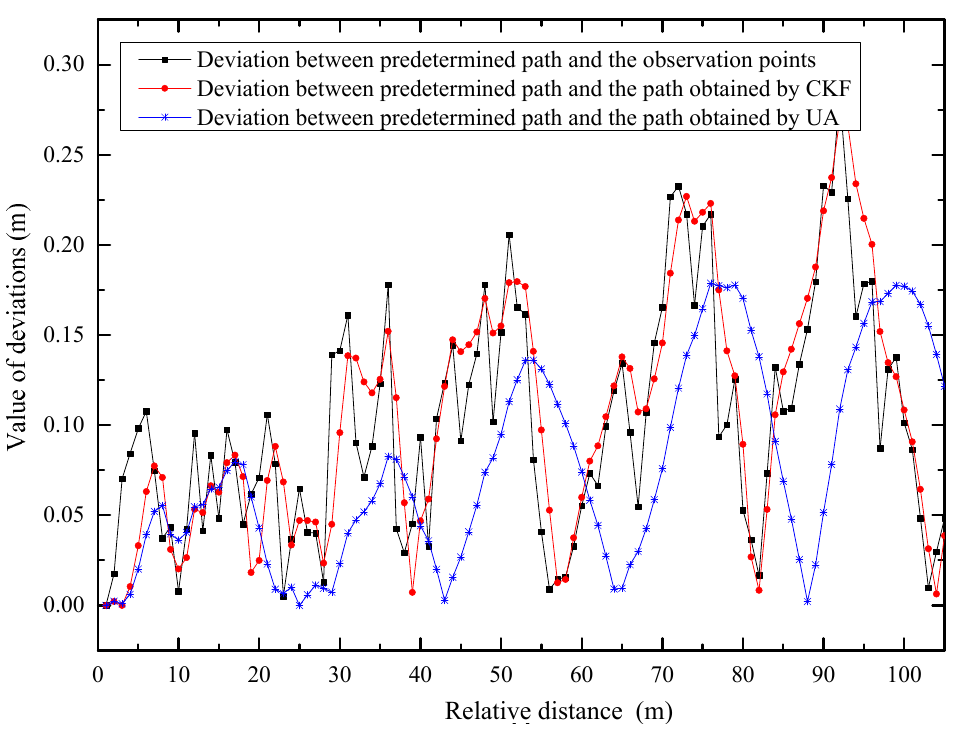
Figure 7. Deviations between the predetermined path and the observation points, the path obtained by using the conventional Kalman filter (CKF) and the updated algorithm (UA).